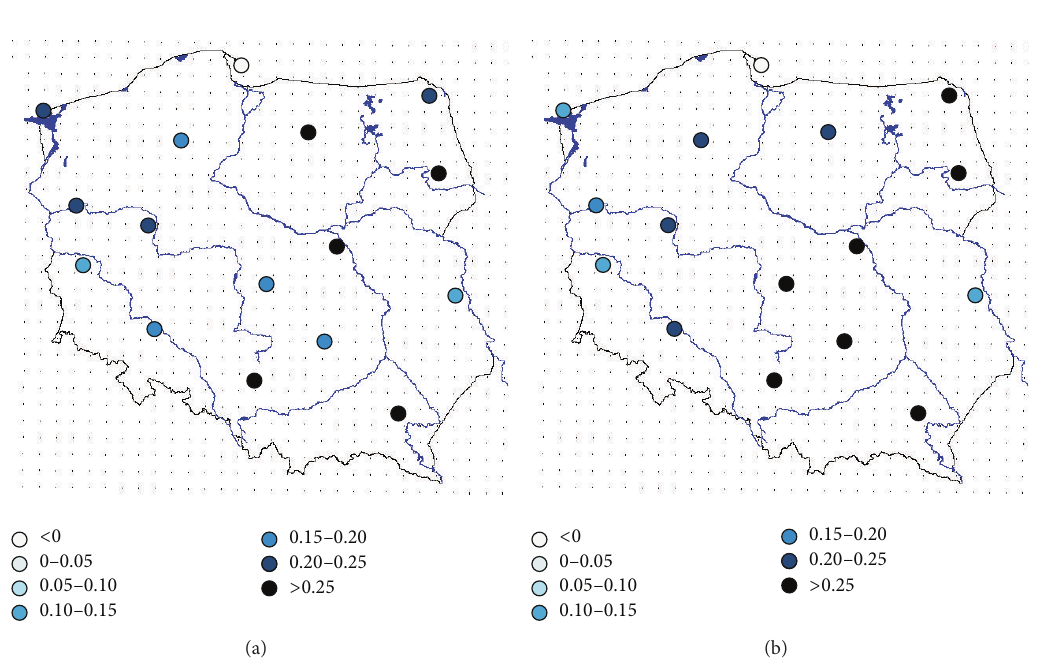
Figure 8: The annual runoff coefficient for the control period 1961–1990: (a) based on MPI-M-REMO model and (b) an average value from five